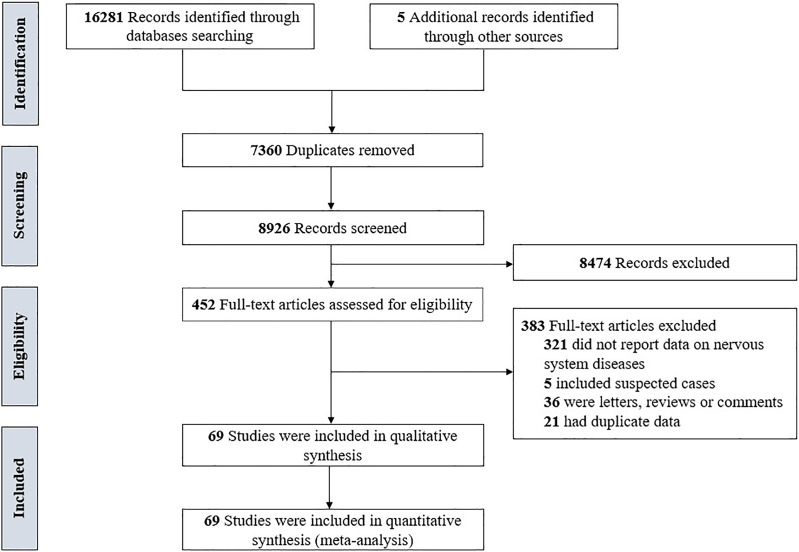
The flowchart of the screening process.